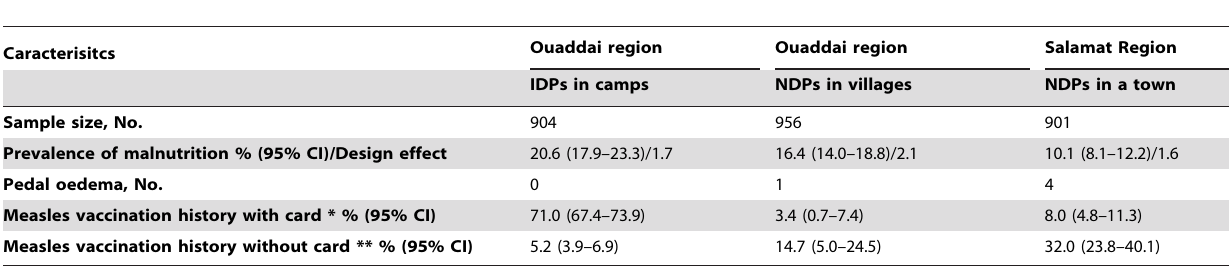
Table 3. Childhood malnutrition and measles vaccination history among children aged 6 to 59 months alive at survey time by Eastern Chad.